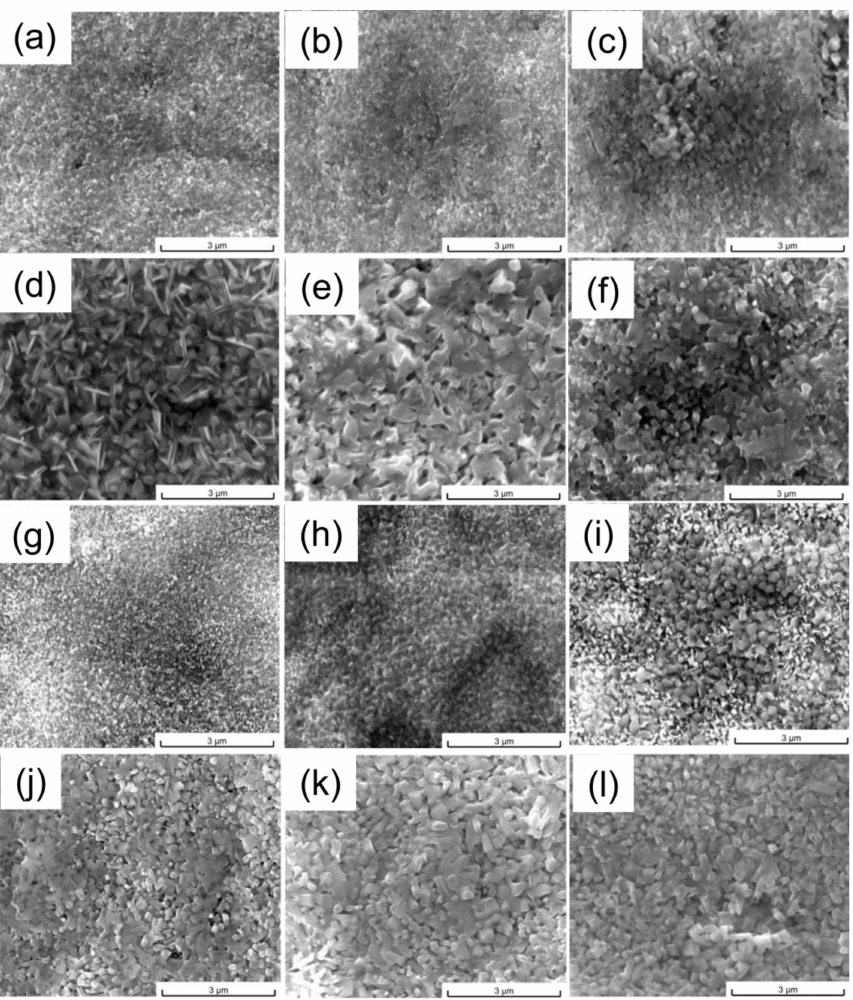
Figure 3. Microscopic SEM images of the removal oxide film surfaces with different heating times: ( a – f ) mechanical grinding, ( a ) 0.5 h, ( b ) 1 h, ( c ) 2 h, ( d ) 4 h, ( e ) 6 h and ( f ) 8 h; ( g – l ) laser cleaning, ( g ) 0.5 h, ( h ) 1 h, ( i ) 2 h, ( j ) 4 h, ( k ) 6 h and ( l ) 8